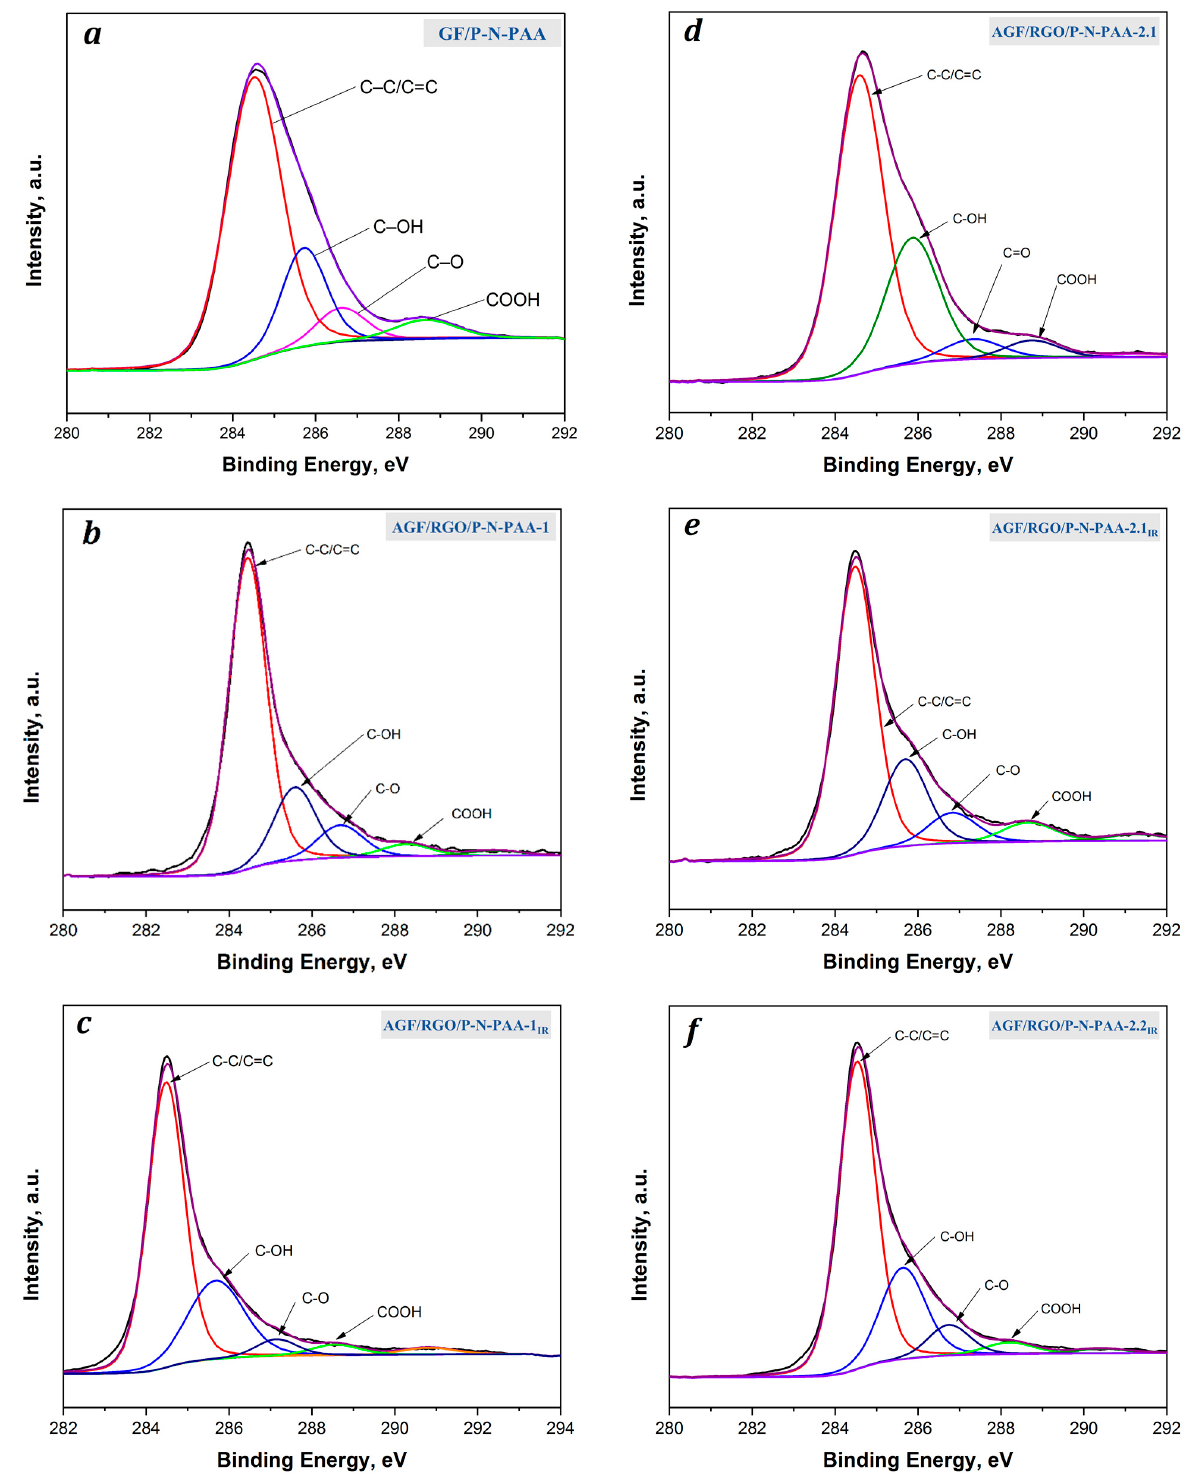
Figure 7. C1s XPS spectra of GF/P-N-PAA-1 ( a ) and AGF/RGO/P-N-PAA before ( b , d ) and after IR heating ( c , e , f ).